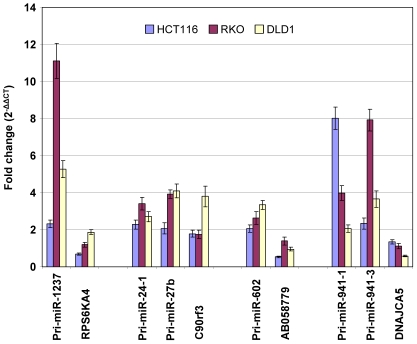
Expression analysis of putative host genes after 5-aza-dC treatment.Real-time RT-PCR analysis was carried out to assess putative host gene expression in response to 5-aza-dC treatments in HCT116 (blue), RKO (dark pink), and DLD1 (yellow). The changes in embedded miRNA expression were also plotted for side-by-side comparisons. All expressions were internally normalized to the expression levels of GAPDH, and normalized expression for each host gene and miRNA before 5-aza-dC treatments was set to 1.